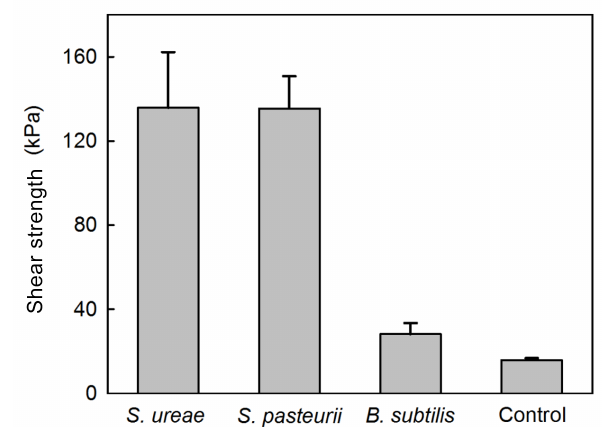
Figure 3. Direct shear strengths ( τ , kPa) of treated sands (SE, n = 3).